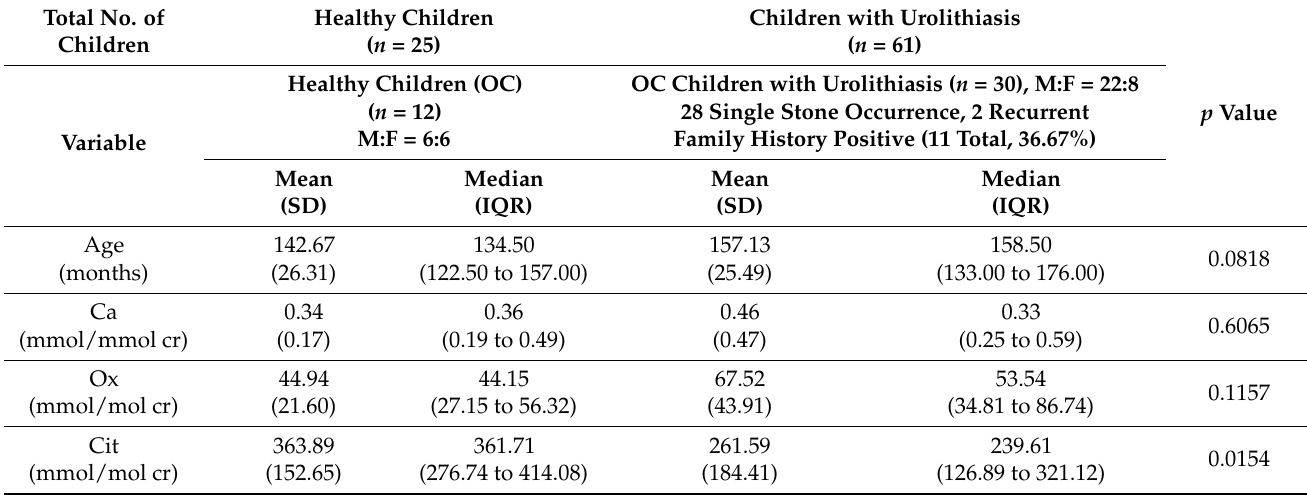
Table 2. Descriptive statistics and Mann–Whitney U-test for OC with urolithiasis and matched control group of healthy children (M = male, F =